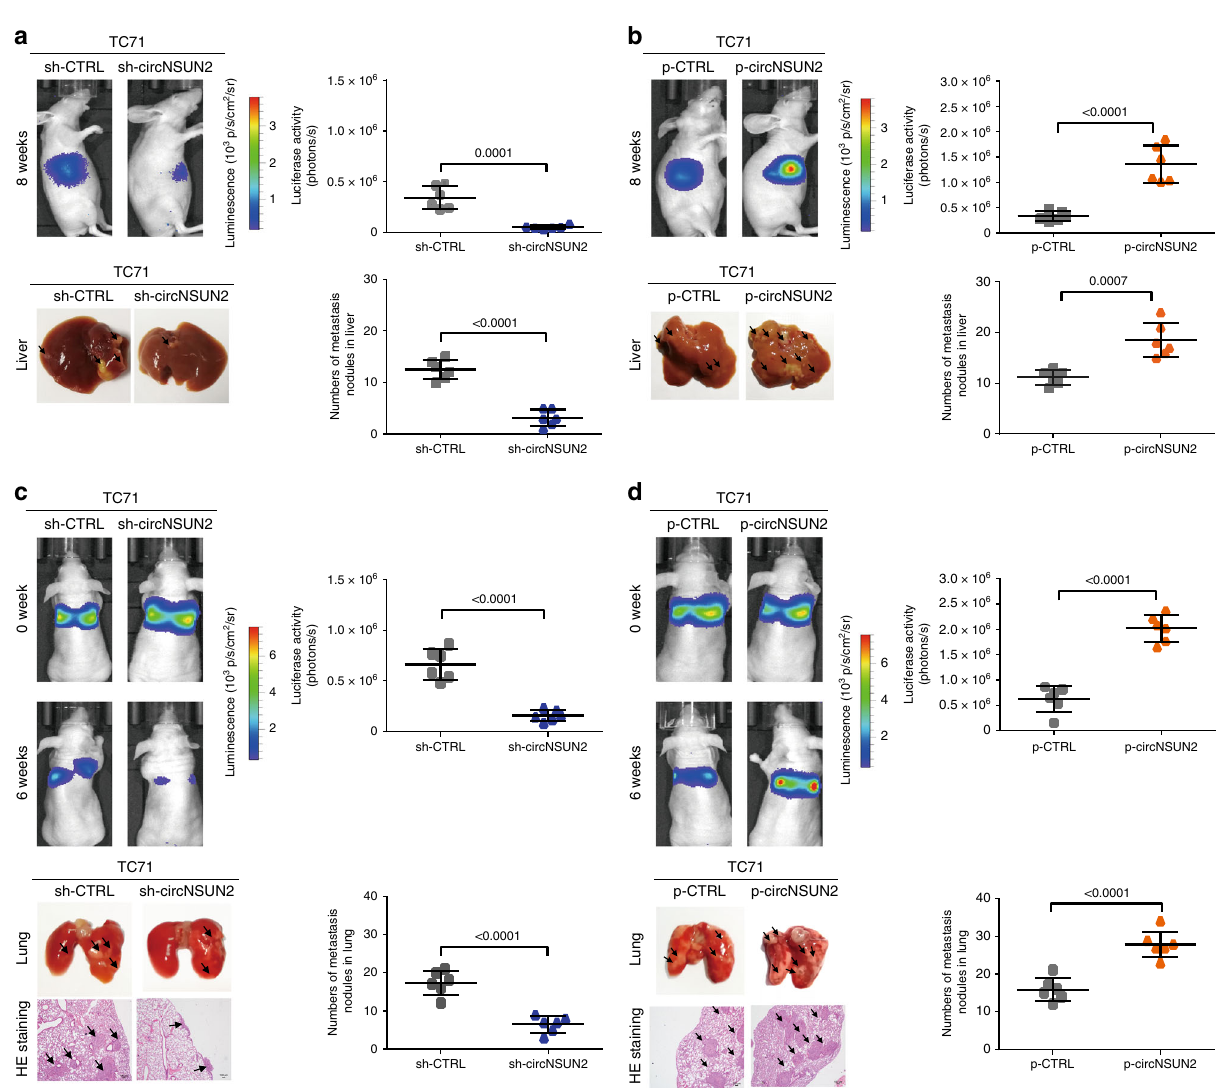
Fig. 3 CircNSUN2 promotes metastasis of CRC. a , b Decreased ( a ) or increased ( b ) tumor metastasis formed in the livers of mice through the inferior hemispleen implantation of circNSUN2-konckdown ( a ) or circNSUN2-overexpression ( b ) TC71 PDX cells. Top, left, representative bioluminescent images of livers for each experimental group at 8 weeks. Top, right, statistical analysis of bioluminescent tracking plots. Bottom, left, representative liver. Bottom, right, the number of metastatic nodules formed in the lungs of mice for each group ( n = 6 mice / group). Data represent mean ± S.D.; dot plot re fl ects data points from independent experiment. The P values were determined by a two-tailed unpaired Student ’ s t test. c , d Decreased ( c ) or increased ( d ) tumor metastasis formed in the lungs of mice through vein tail injection of circNSUN2-konckdown ( c ) or circNSUN2-overexpression ( d ) PDX cells. Top, left, representative bioluminescent images of lungs for each experimental group during 6 weeks. Top, right, statistical analysis of bioluminescent tracking plots. Bottom, left, representative lung and representative HE staining of lung metastatic lesions, Original magni fi cation, ×4, scale bar, 100 µ m. Bottom, right, the number of metastatic nodules formed in the lungs of mice for each group ( n = 6 mice/group). Data represent mean ± S.D.; dot plot re fl ects data points from independent experiment. The P values were determined by a two-tailed unpaired Student ’ s t test. Source data are provided as a Source Data fi circNSUN2 is required for IGF2BP2 interaction. Super shift experiments indicated that IGF2BP2 speci fi cally binds to this sequence. When the concentration of IGF2BP2 protein was increased, the concentration of the circNSUN2/IGF2BP2 mixture was also increased. Mutation of the CAUCAU motif signi fi cantly reduced the concentration of the mixture (Fig. 5e, bottom). Our data collectively reveal that IGF2BP2 binds to the CAUCAU